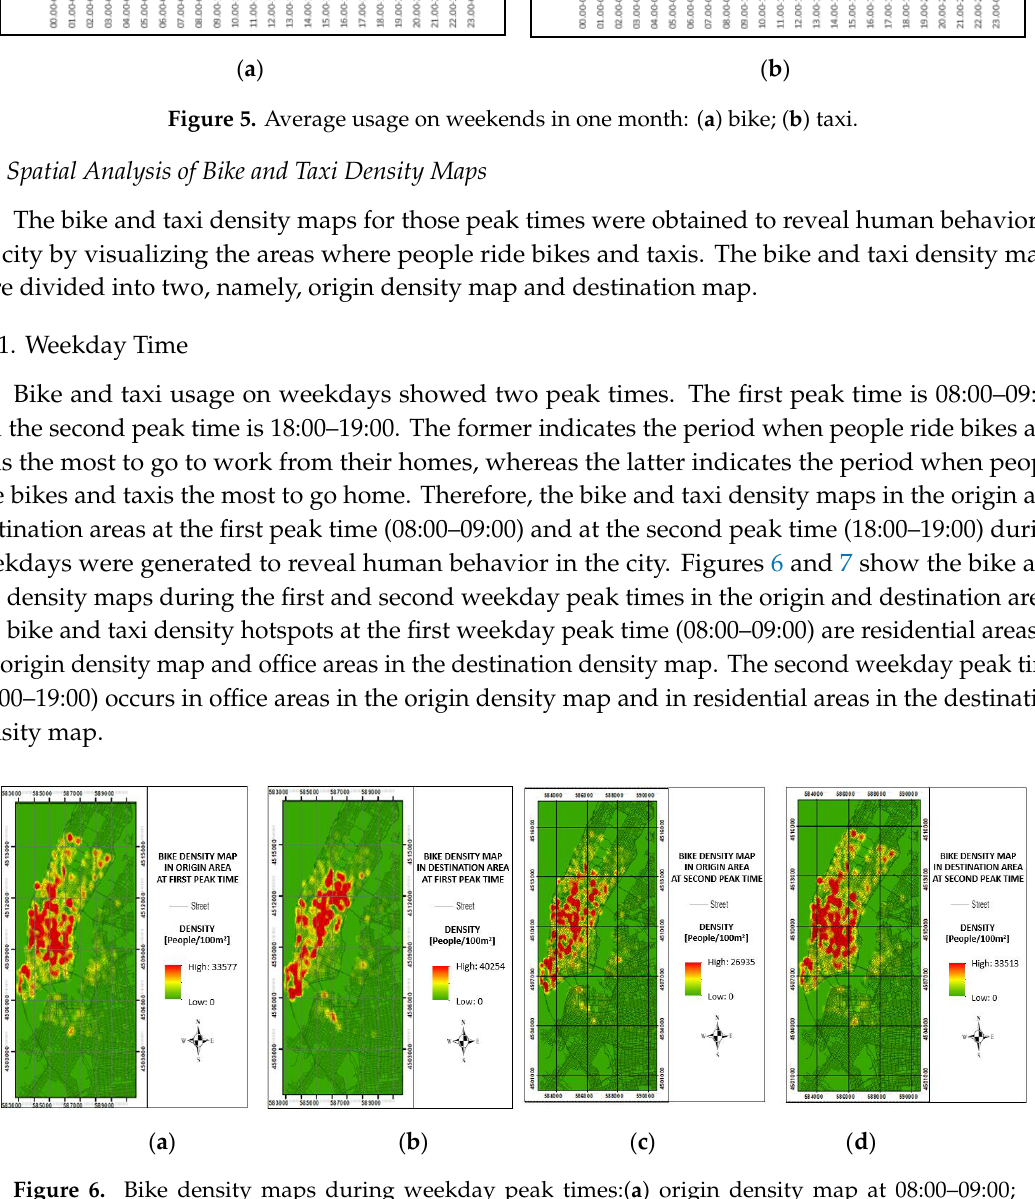
Figure 7. Taxi density maps during weekday peak times: ( a ) origin density map at 08:00 – 09:00; ( b ) destination density map at 08:00 – 09:00; ( c ) origin density map at 18:00 – 19:00; ( d ) destination density map at 18:00 – 19:00. 4.2.2. Weekend Time During weekends, bike usage shows one peak time at 17:00 – 18:00, whereas taxi usage shows one peak time at 18:00 – 19:00. This result indicates a one-hour difference in peak times and a similar pattern. Weekend peak times refer to the periods when people ride bikes and taxis the most to go to entertainment areas from their home and vice versa. The origin and destination density maps of bike usage during the weekend peak time of 17:00 – 18:00 and taxi usage during the weekend peak time of 18:00 – 19:00 were generated to reveal human behavior in the city. In Figure 8, the locations of where people are during the weekend peak times of bike and taxi usage in the area of origin and destination area are residential and entertainment areas. Moreover, the locations of where people are during the second weekend peak time of bike usage in the area of origin and destination area reflect entertainment and residential areas. Generally, people in the area of origin are located in a residential area during the first peak time on a weekday, and their destination area is an office area. During the second peak time on a weekday, people originate their journeys in an office area, and their destination area is a residential area. The weekend peak times refer to the periods when people ride bikes and taxis the most to go to entertainment areas from their homes and vice versa. On the basis of bike and taxi usage, human behavior in a city can be identified and analyzed. Bike and taxi usage hotspots in traffic source-sink areas are related to traffic intensities and land use patterns [4,10].